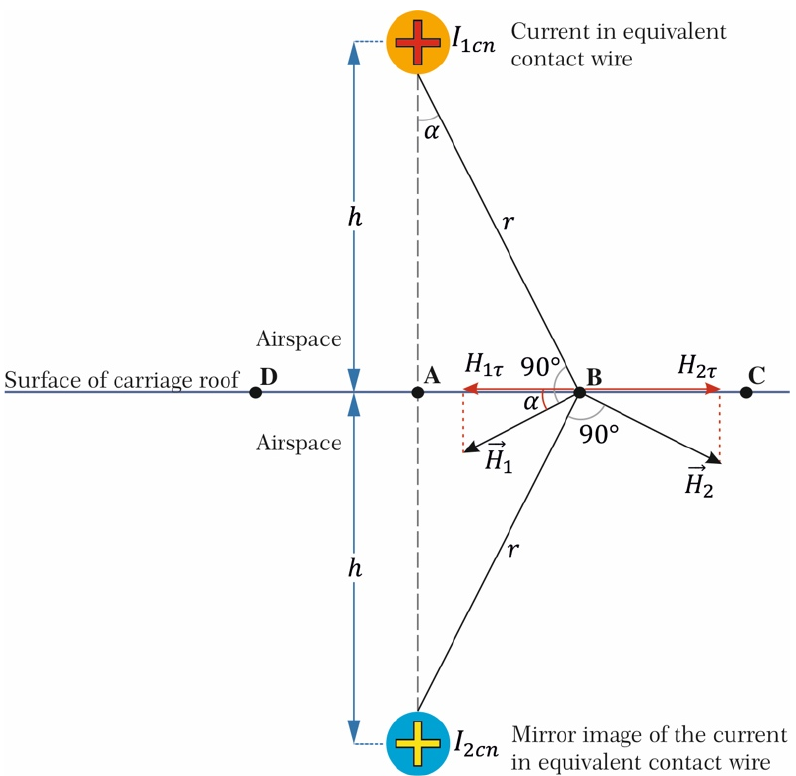
Figure 3. Calculation scheme for the mirror image method of the magnetic field on the roof surface of the carriage, created by the traction current in the equivalent contact wire.